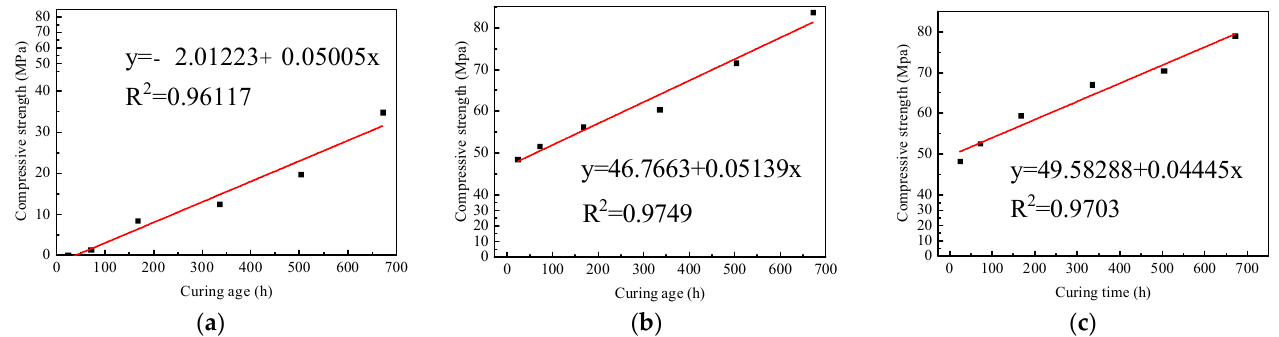
Figure 1. Fitting results of compressive strength of alkali-activated mortars under standard curing: ( a ) FB; ( b ) GB; ( c ) MB.